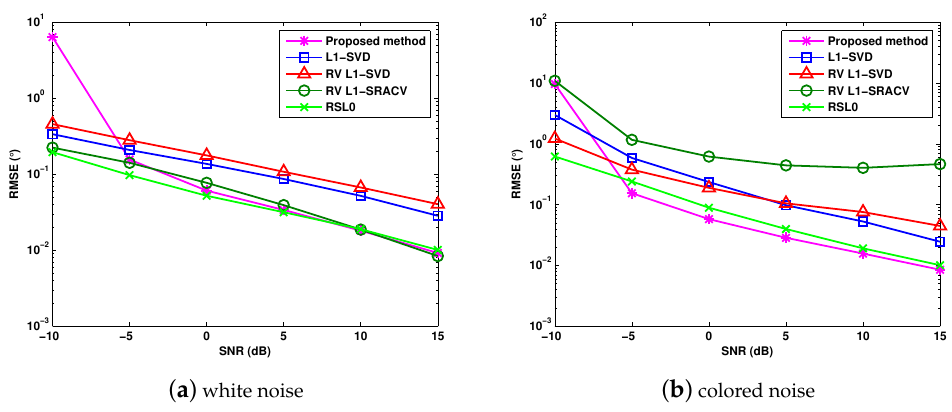
Figure 4. RMSE versus SNR (signal-to-noise ratio) for different sparse DOA (direction-of-arrival) estimation